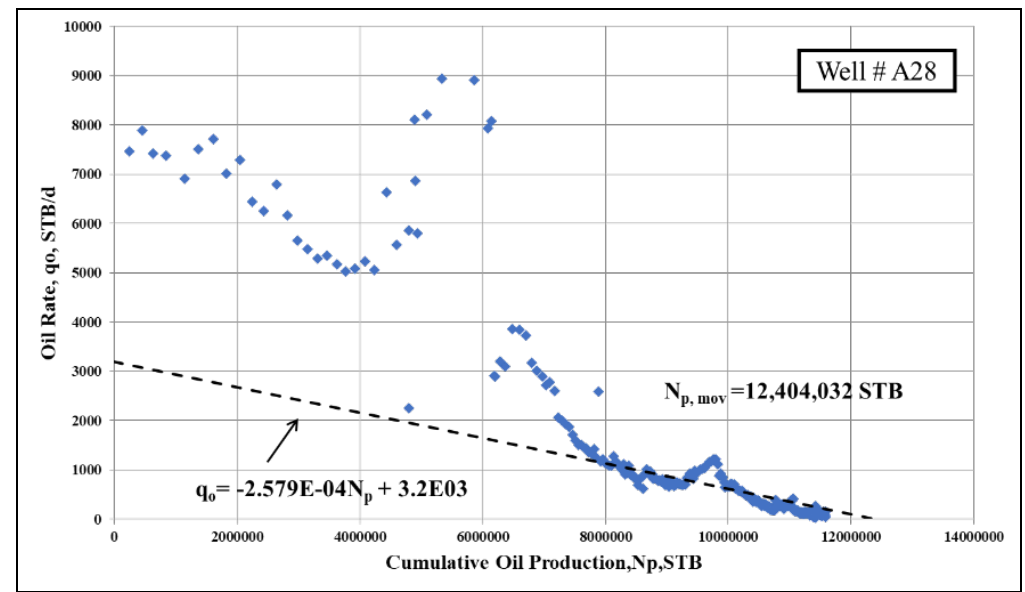
Figure 7. Oil production rate versus cumulative oil production for well